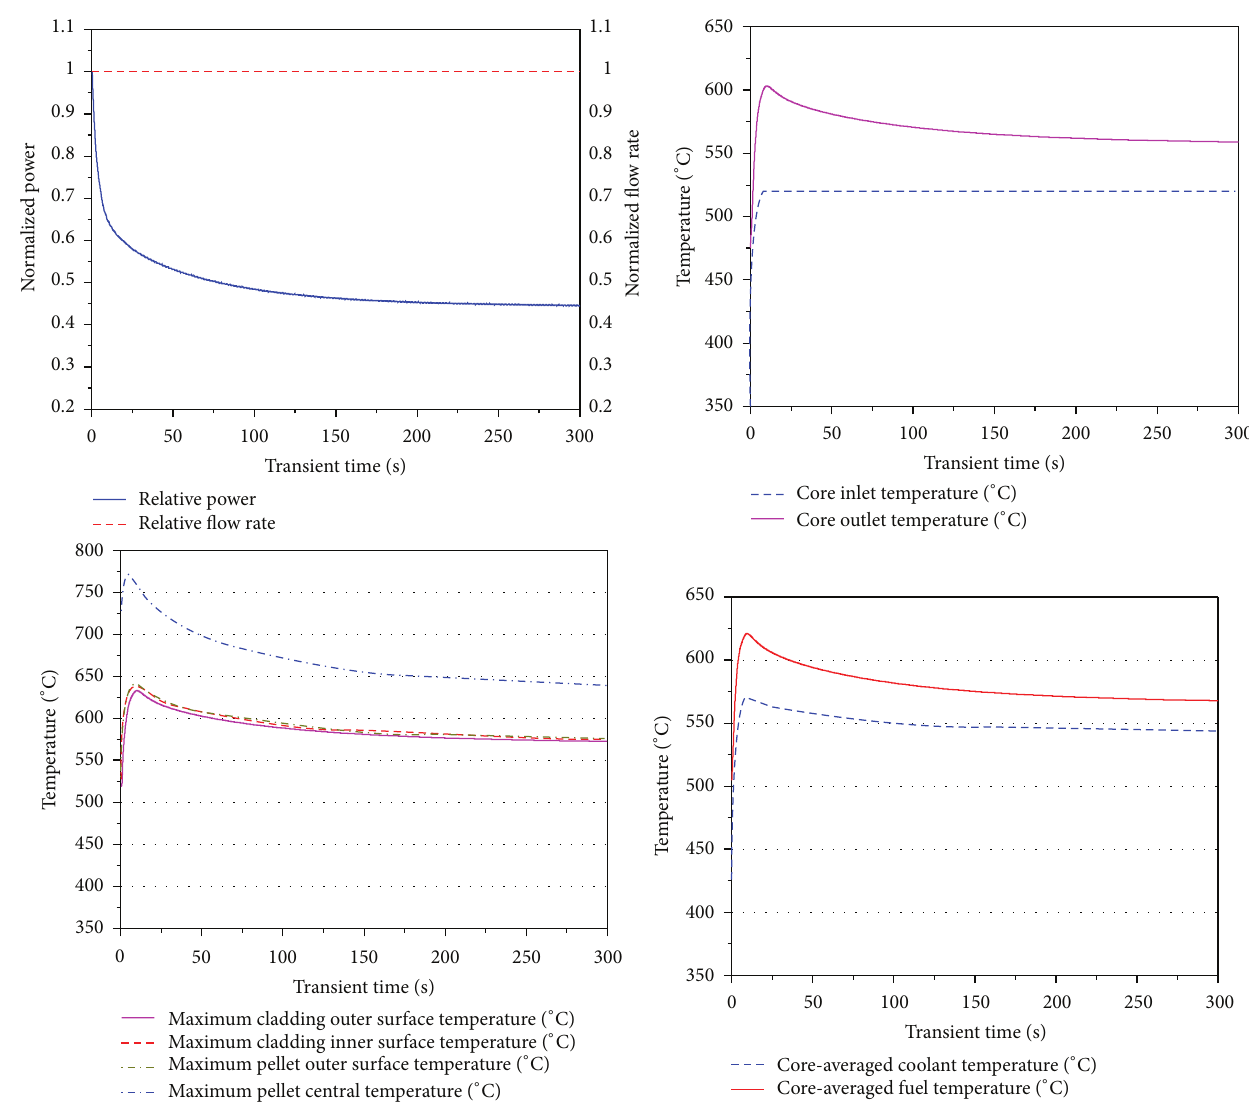
Figure 21: Core key parameters response during